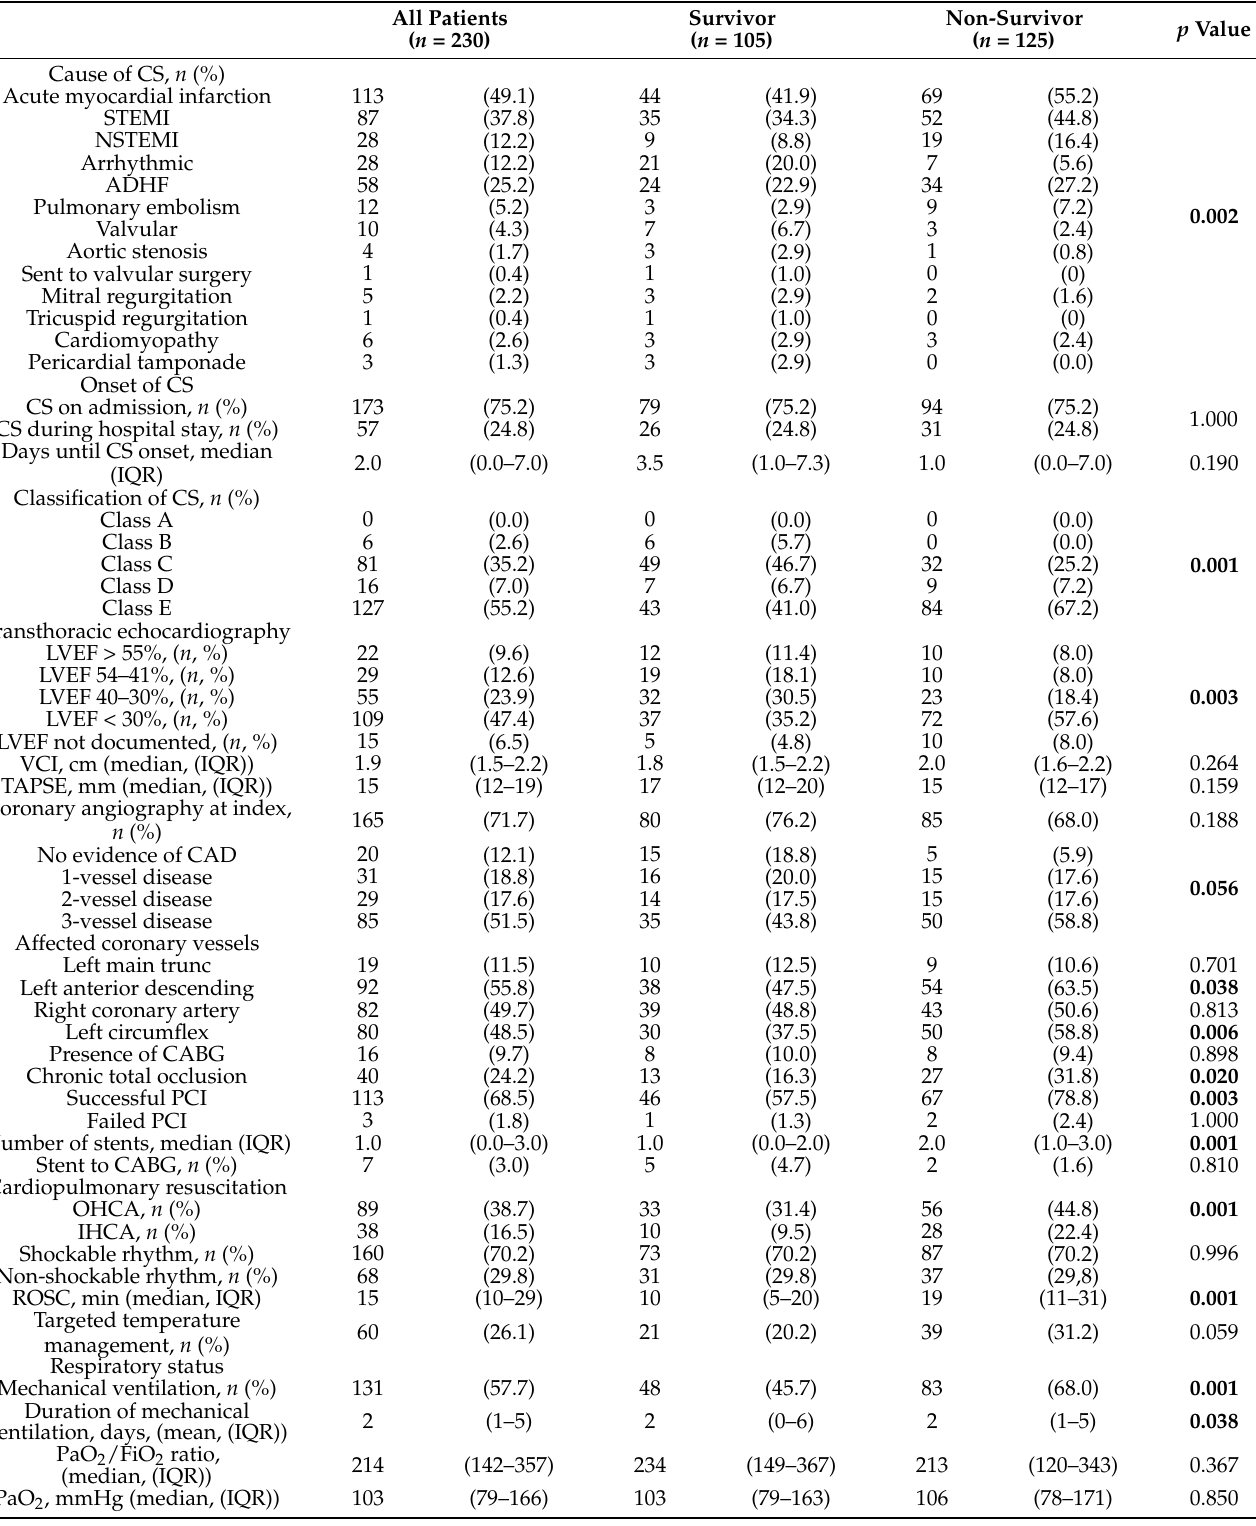
Table 2. Shock-related data, follow-up data, and